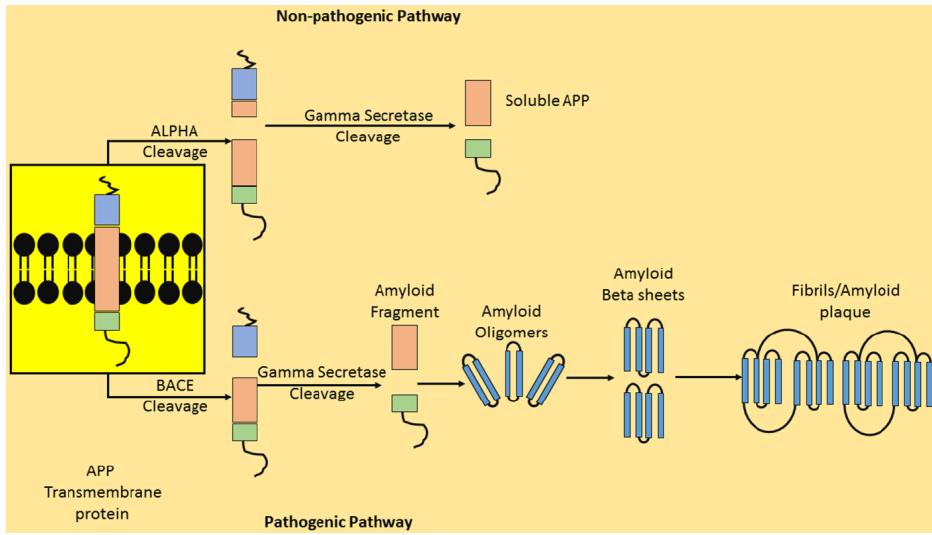
Figure 1. The amyloid cascade hypothesis. BACE—Beta-site APP-cleaving enzyme; APP—Amyloid precursor protein.